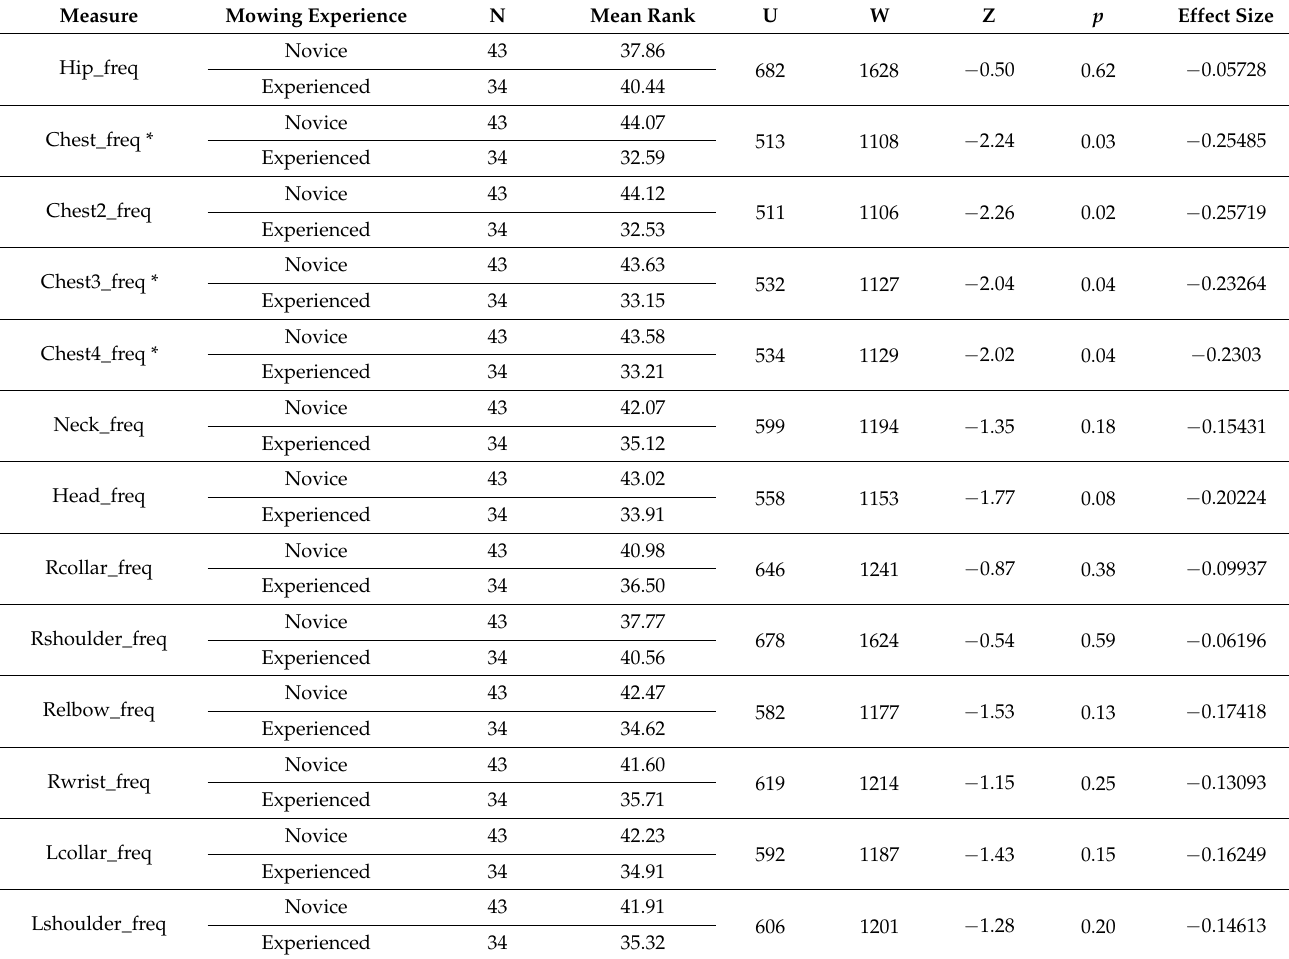
Table 6. Results for Different Mowing Experience (Freq.